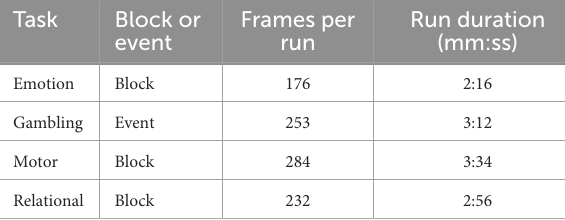
TABLE 1 Type and duration of each task protocol analyzed.